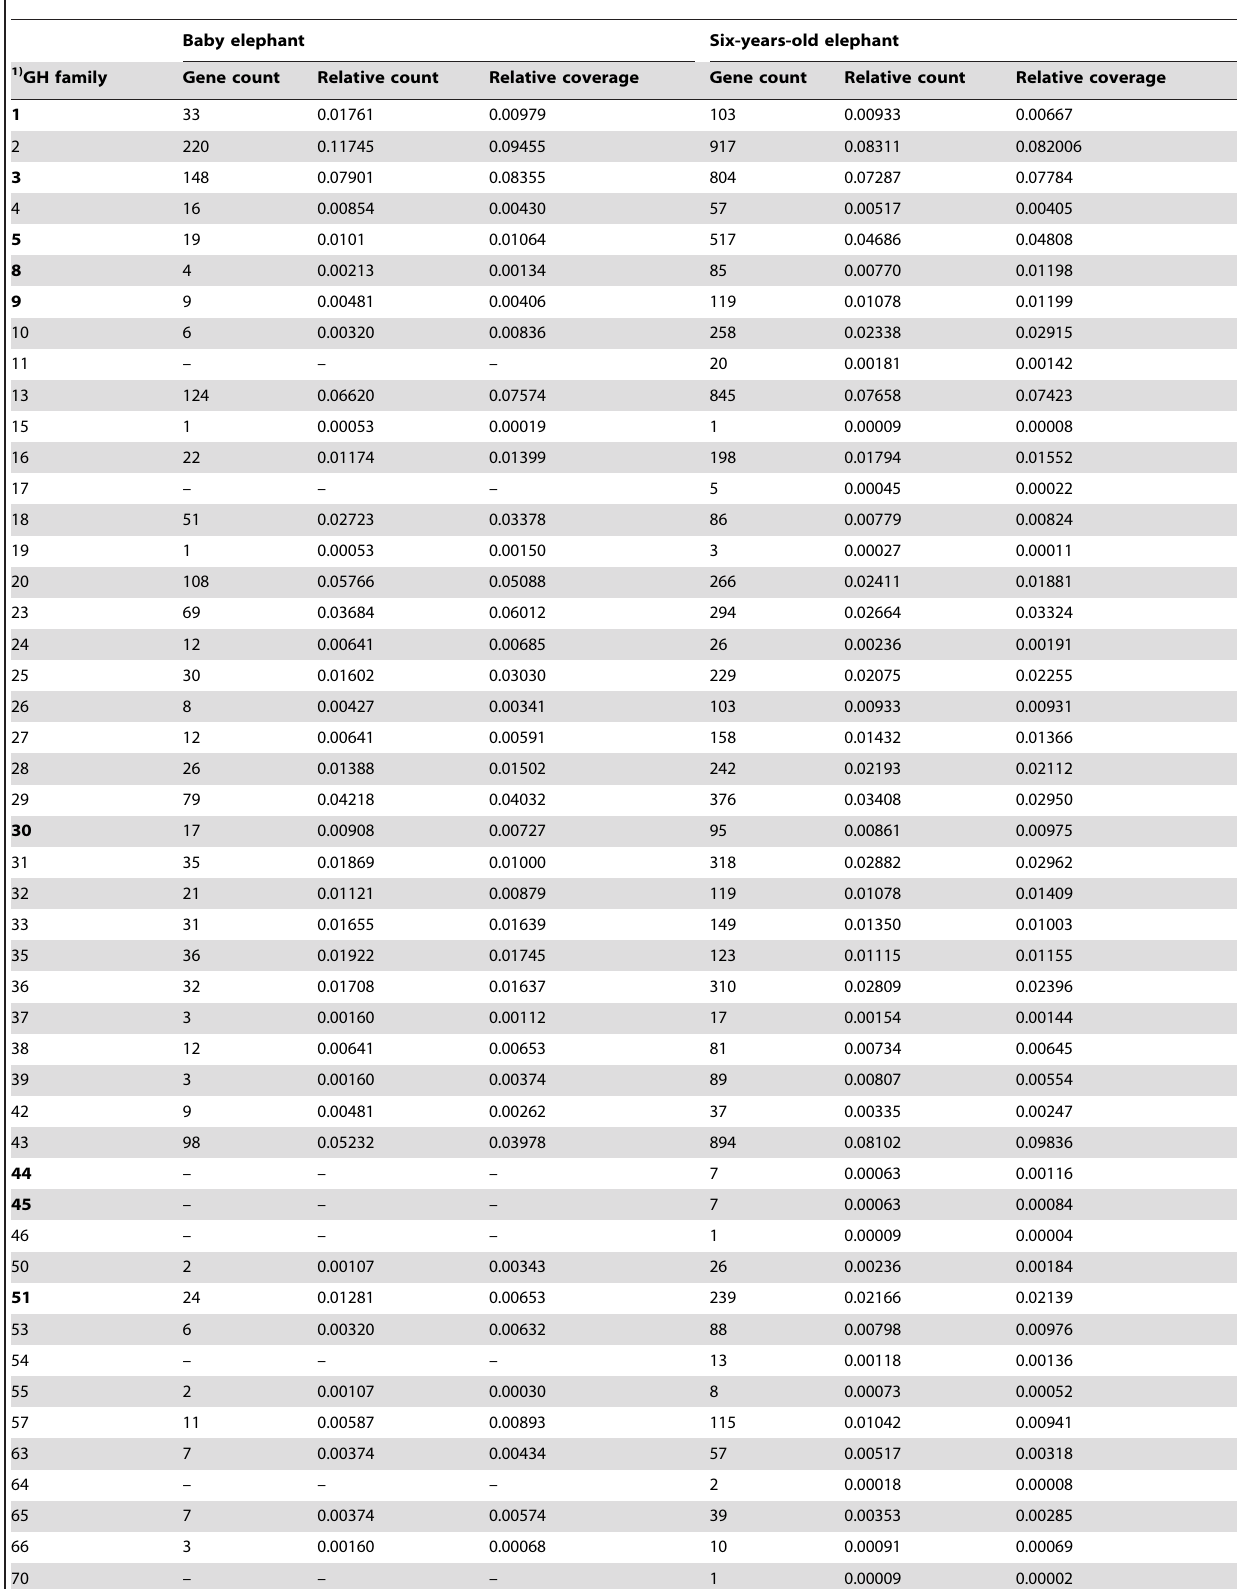
Table 3. Gene count, relative gene count and relative coverage of genes for families of carbohydrate-active enzymes discovered in the sequences of the elephant feces samples according to